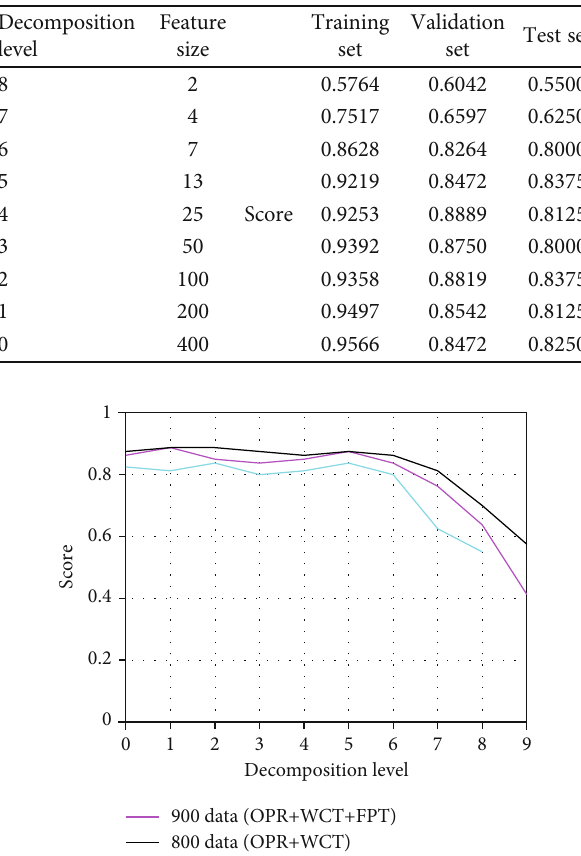
Table 3: The sensitivity analysis of the decomposition level using the 400 oil production rates only.